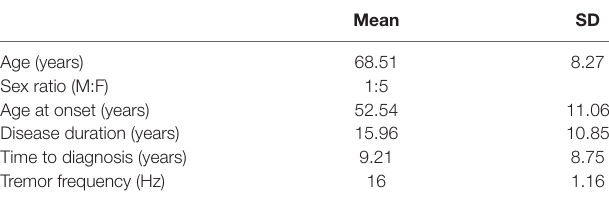
TaBle 1 | Clinical and demographic characteristics of 40 POT